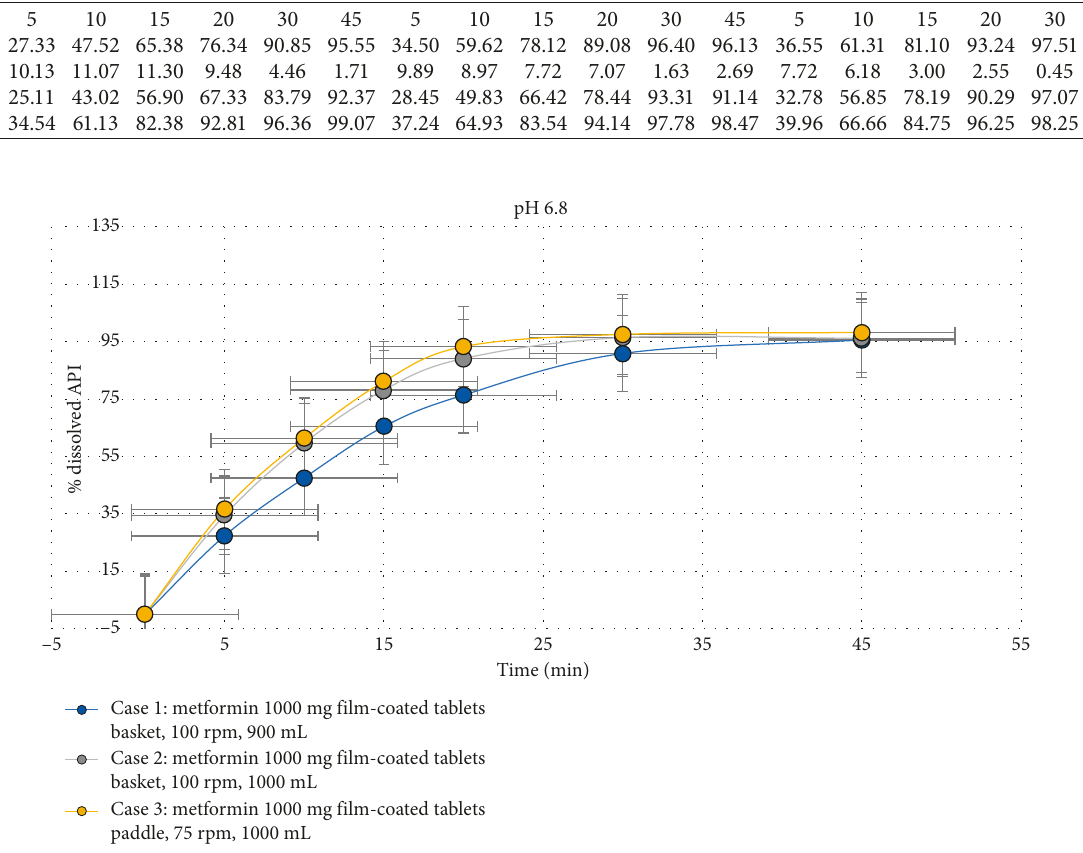
Figure 2: Dissolution profile of metformin 1000mg film-coated tablets using different apparatus and volume of the